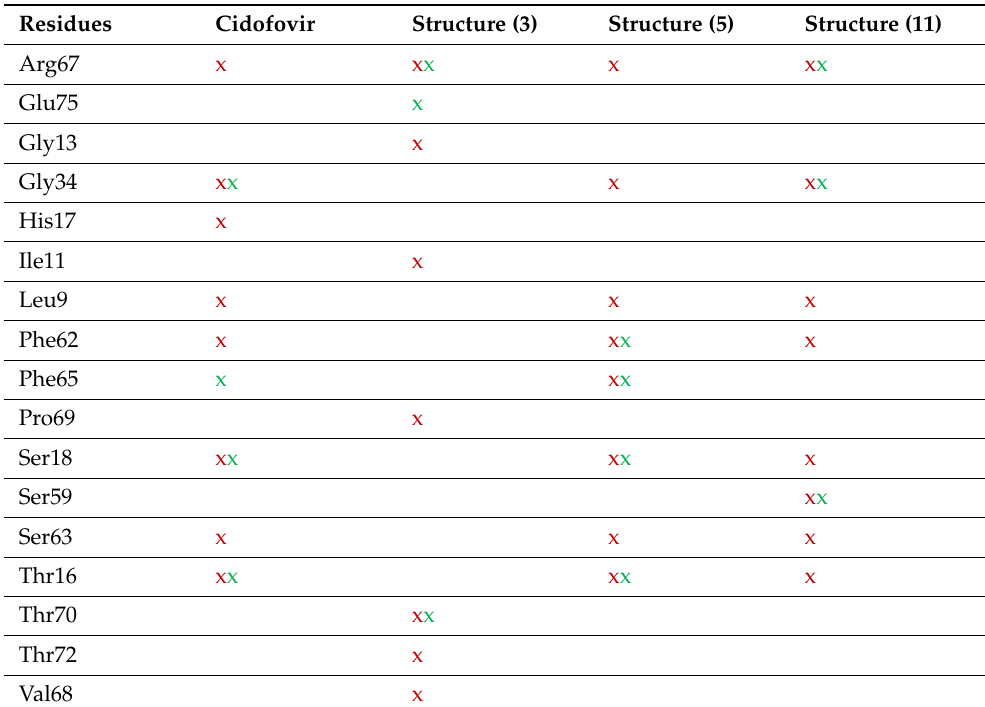
Table 3. Showing the interacting residues of cowpox OMCP protein (F chain) with cidofovir and the best structures. Cidofovir Structure (3) Structure (5) Structure